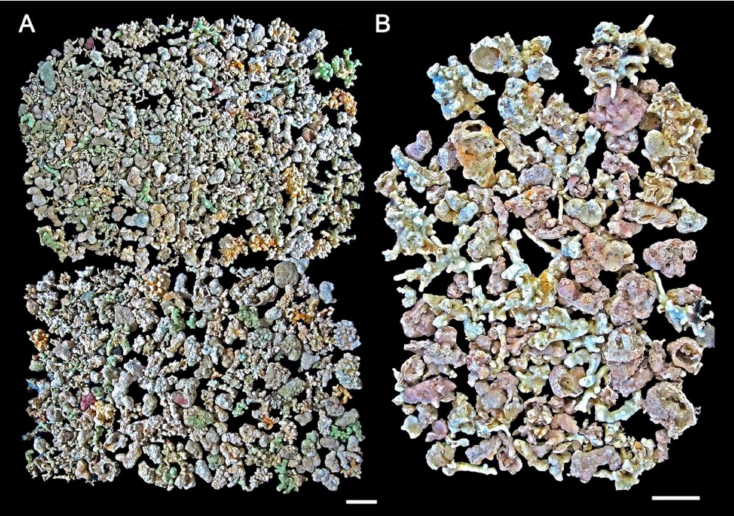
Figure 8. Fruticose (maërl) and small encrusting rhodoliths with associated shells: ( A ) from site 2 of the north sector, at 30 m depth; ( B ) from site 4 of the central sector, at 47 m depth. Scale bars = 1